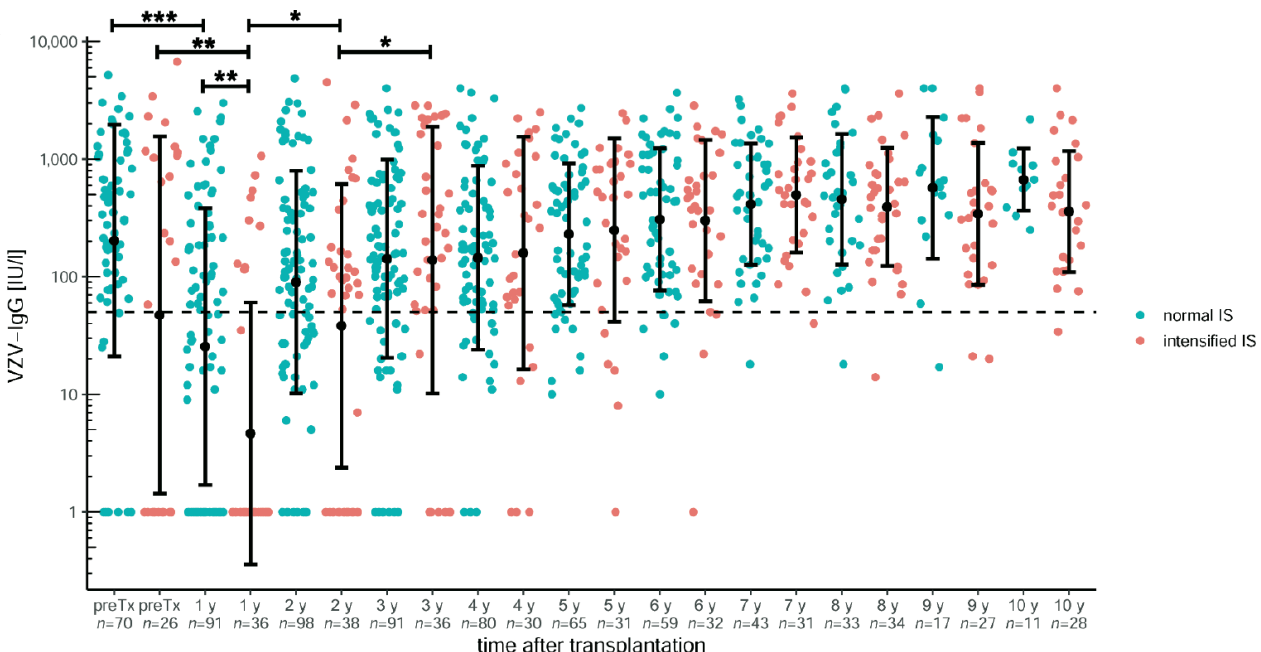
Figure 4. VZV-specific antibody course in paediatric liver transplant recipients over ten years after transplantation dependent on normal (monotherapy with ciclosporin A or tacrolimus) or intensified (monotherapy supplemented by prednisolone or mycophenolate mofetil) immunosuppression (IS). At the first annual follow-up after transplantation, the titres dropped significantly in both groups, and children with intensified immunosuppression also had a significantly lower titre compared with those with normal immunosuppression. At the second annual check-up, titres increased again and did not show any further difference. The y -axis is scaled logarithmically. Data is shown as mean ± standard deviation. The dashed line marks the threshold for serological protection. Significant data is marked as follows: * <0.05, ** <0.01, *** <0.001.